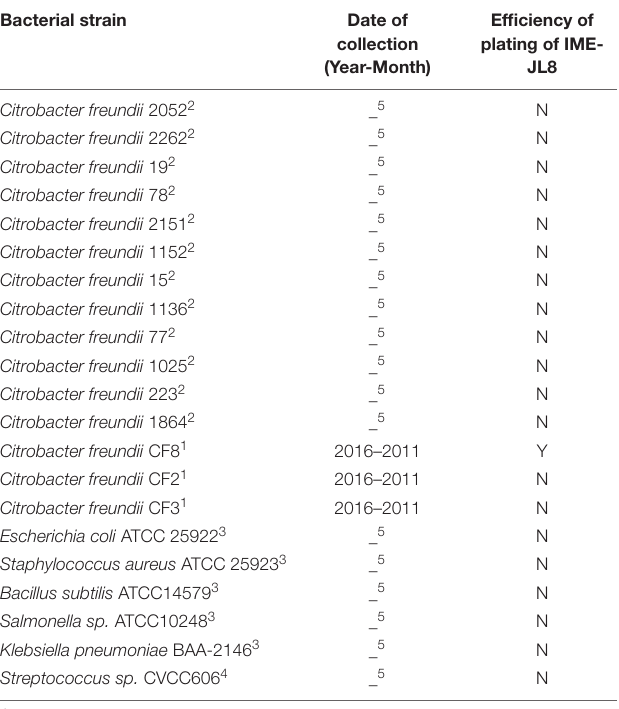
TABLE 1 | Bactericidal spectrum of IME-